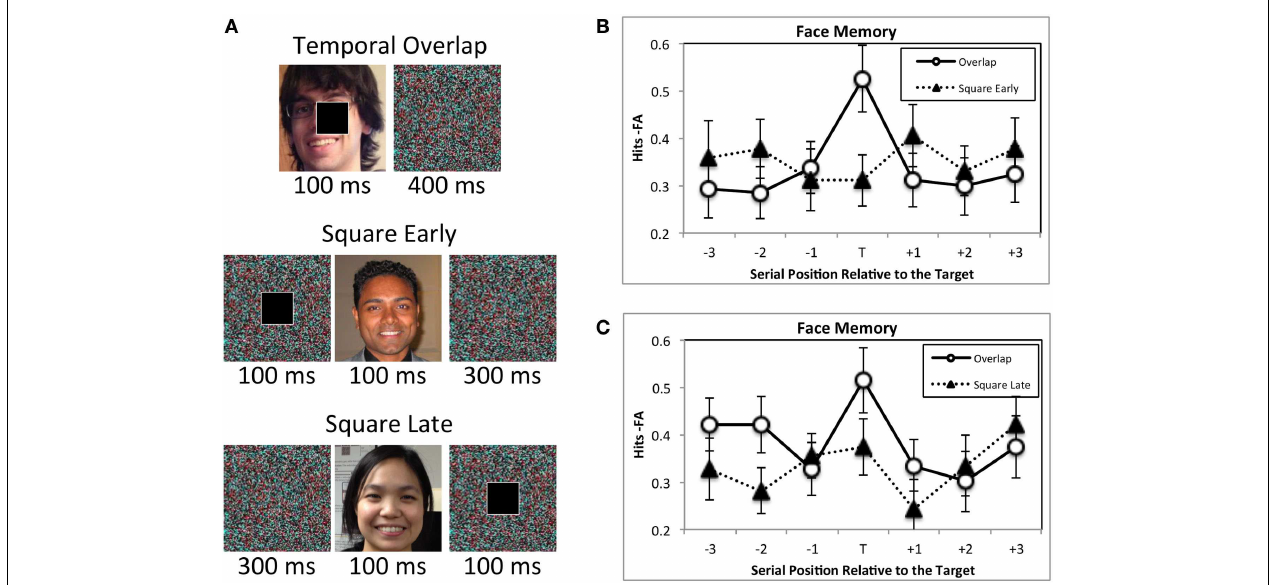
before the face onset (Square Early condition). In the second experiment, temporal overlap blocks were interspersed with blocks in which the square onset 100ms after the face (Square Late condition). (B,C) Target detection enhanced memory for faces only when the target and face overlapped in time. It did not facilitate memory for images that occurred 100ms earlier (B) or 100ms later (A) . Error bars represent ± 1 standard error of the mean. Adapted from Swallow and Jiang